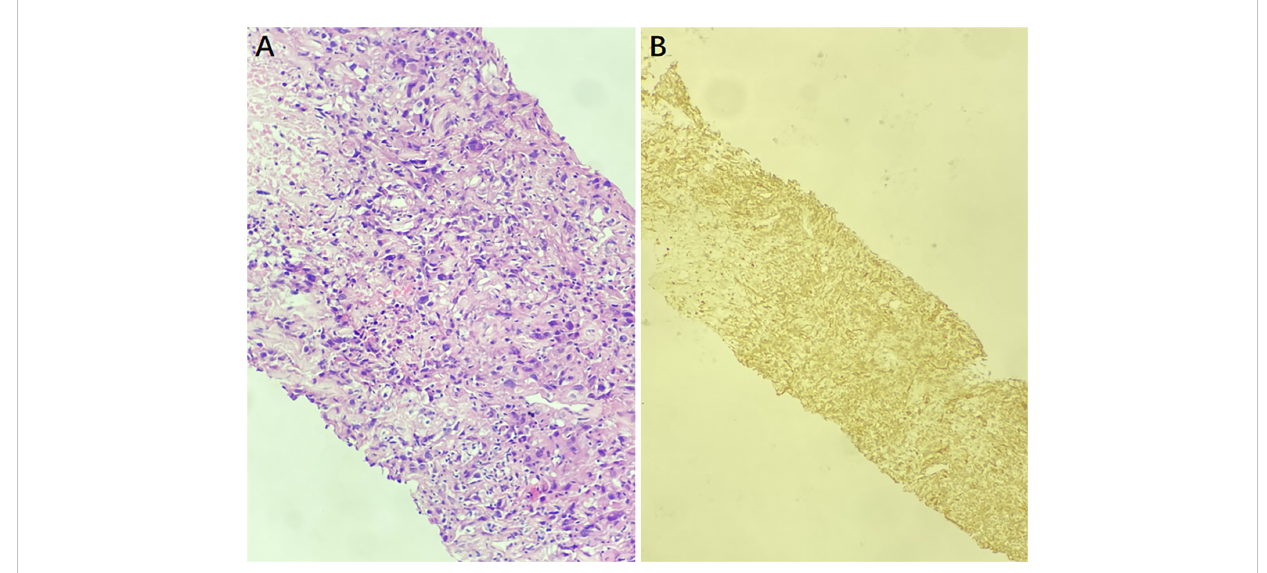
FIGURE 3 The puncture biopsy specimen pathological fi ndings show in fi ltration of myo fi broblasts, and there is no in fl ammatory cells (hematoxylin-eosin ×200) (A) . The immunohistochemistry staining for SMA was positive, indicating a LGMS (B) .